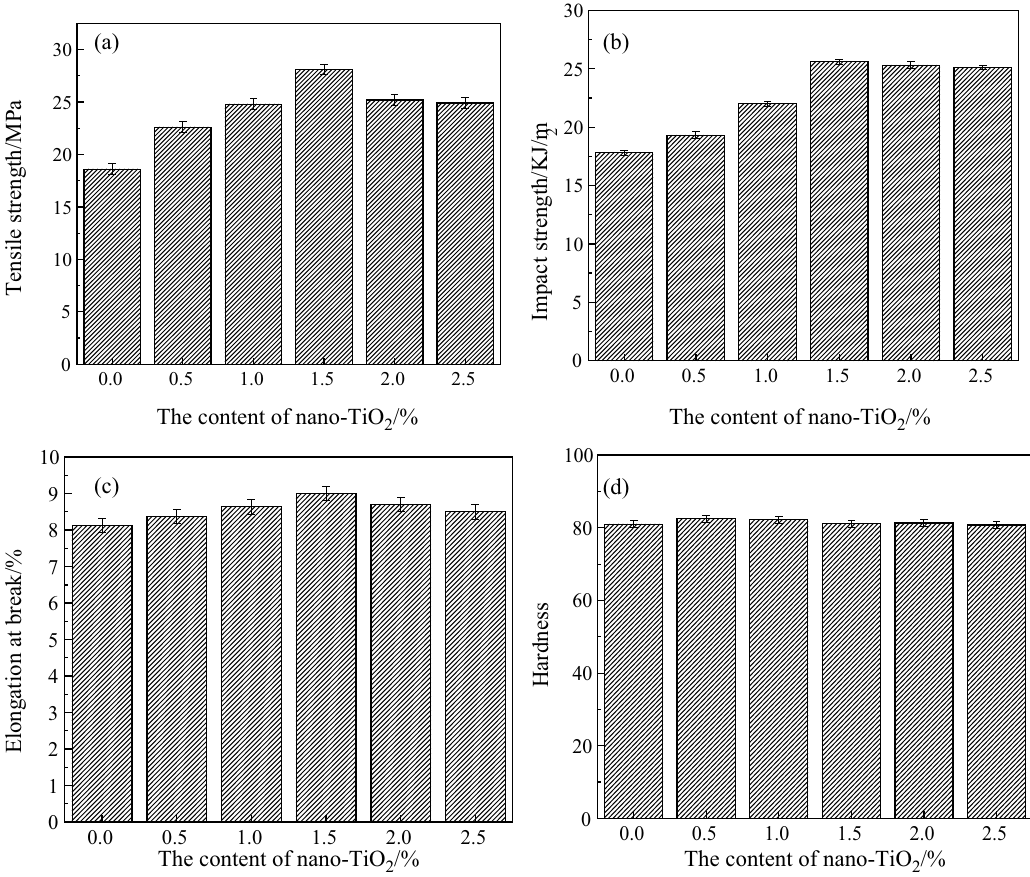
Figure 11: E ff ect of di ff erent TiO 2 content on mechanical properties of molded parts: ( a ) tensile strength, ( b ) impact strength, ( c ) elongation at break, and ( d )